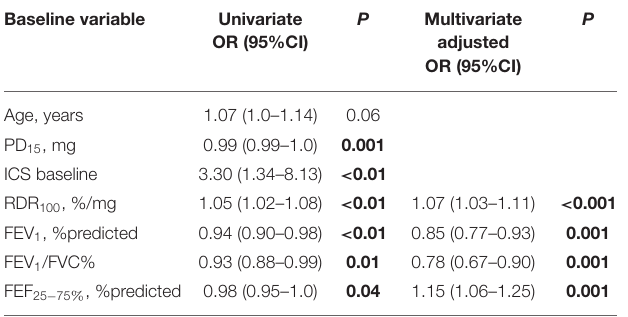
TABLE 6 | Backward stepwise prediction model for persistent AHR on follow up.